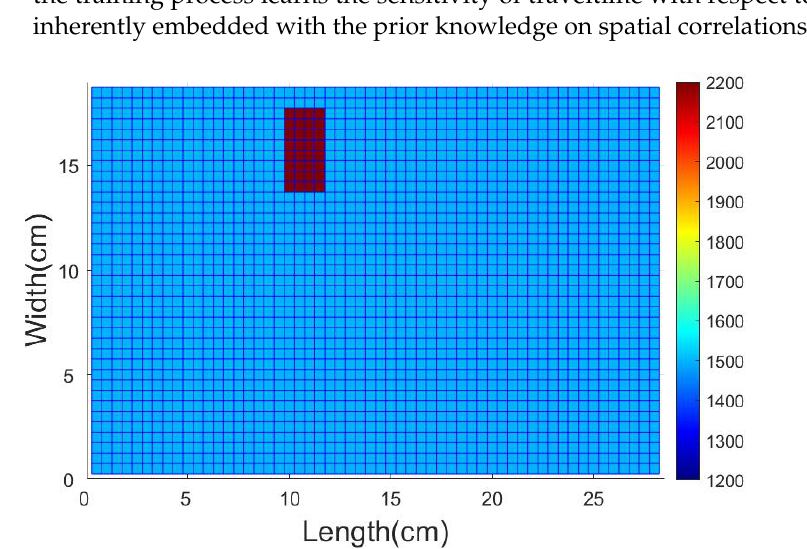
Figure 7. Example of the training model. Red Block: high-velocity block (2200 m/s). Blue region: low-velocity (1500 m/s) background.